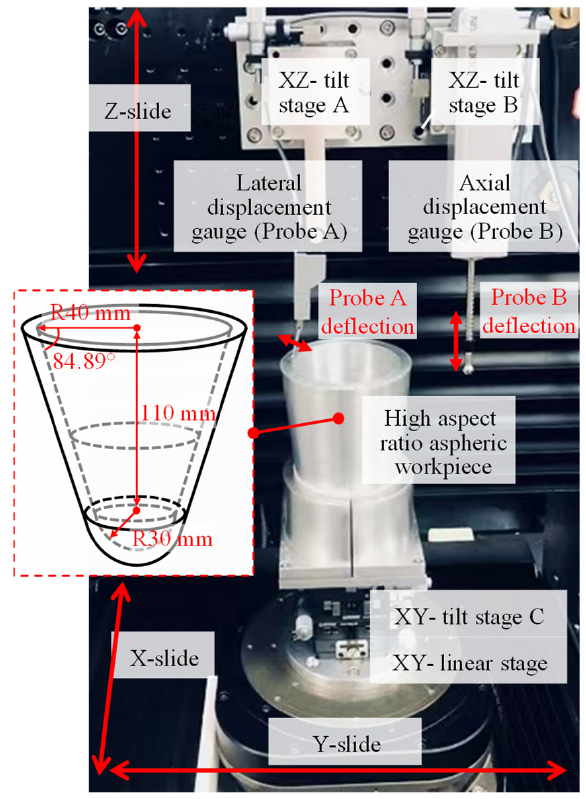
Figure 10. Photograph of the experimental setup.